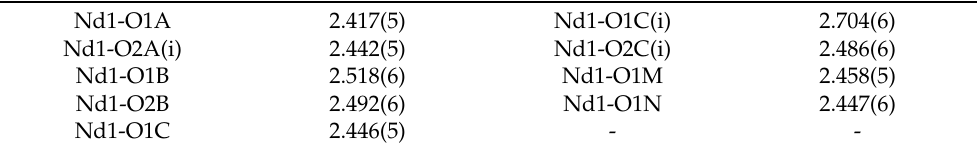
Table 1. Selected bond lengths (Å) for compound 1 [a]. .